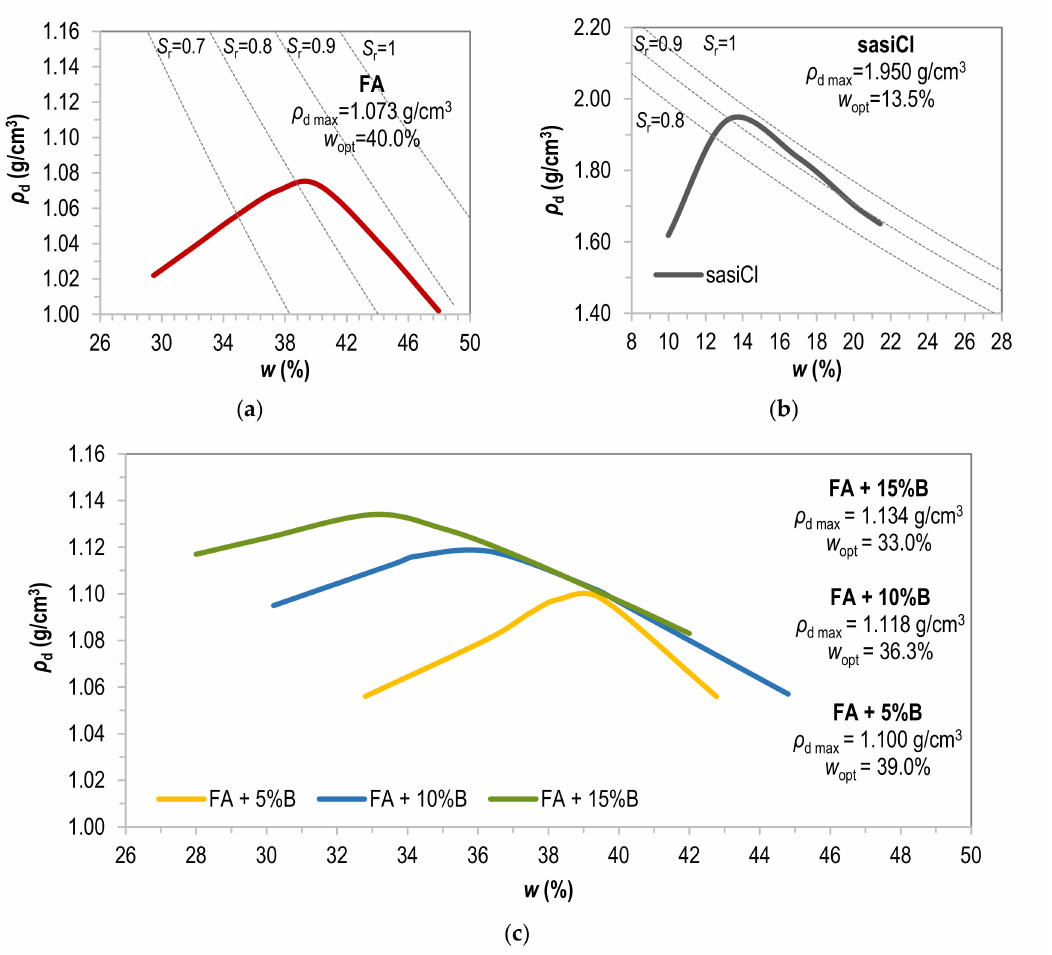
Figure 2. Compaction curves of: ( a ) fly ash without additives; ( b ) sandy silty clay; ( c ) fly ash with the addition of 5, 10, and 15% of